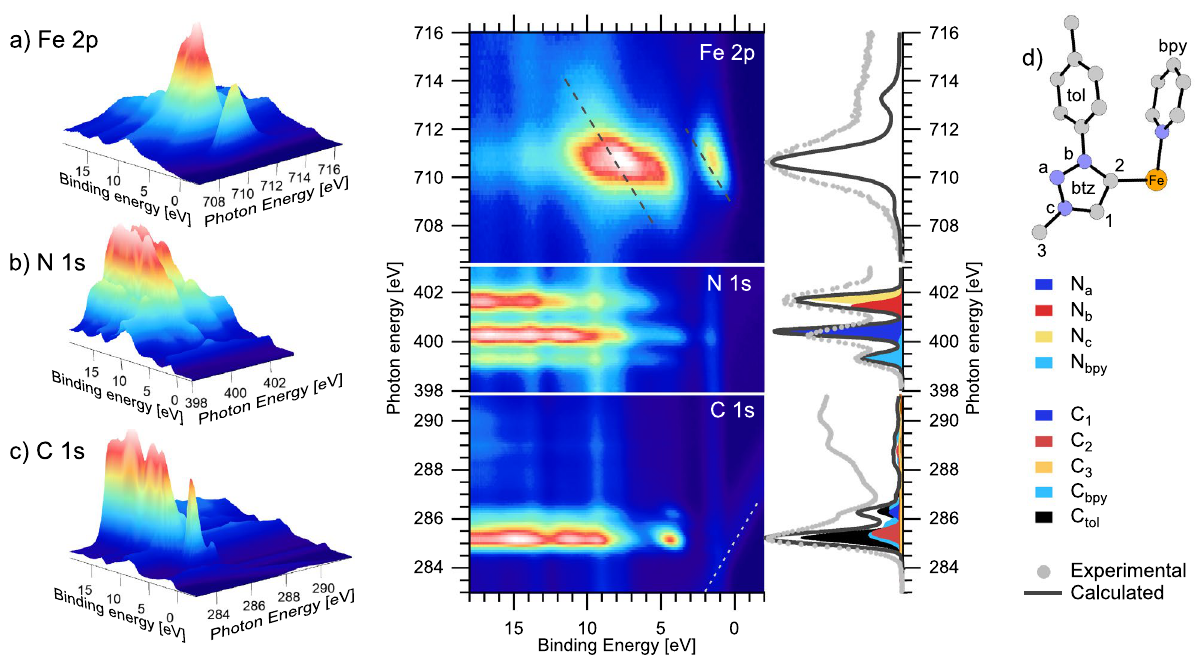
Figure 5. [ Fe II ( btz ) 2 ( bpy ) ] 2 + RPES maps showing (a) Fe 2 p 3 / 2 (top), (b) N 1 s (middle) and (c) C 1 s (bottom) transitions. Grey dashed diagonal lines on the Fe 2 p map indicate paths of constant kinetic energy. The white dotted line marks second order C 1 s photoemission. NEXAFS spectra are presented to the right of the maps. The experimental partial electron yield NEXAFS spectrum is plotted with light grey dots and the calculated NEXAFS spectrum is plotted as dark grey lines. The contribution from the different atoms to the calculated spectra are shown by coloured areas, as detailed in the key and molecule scheme (d)